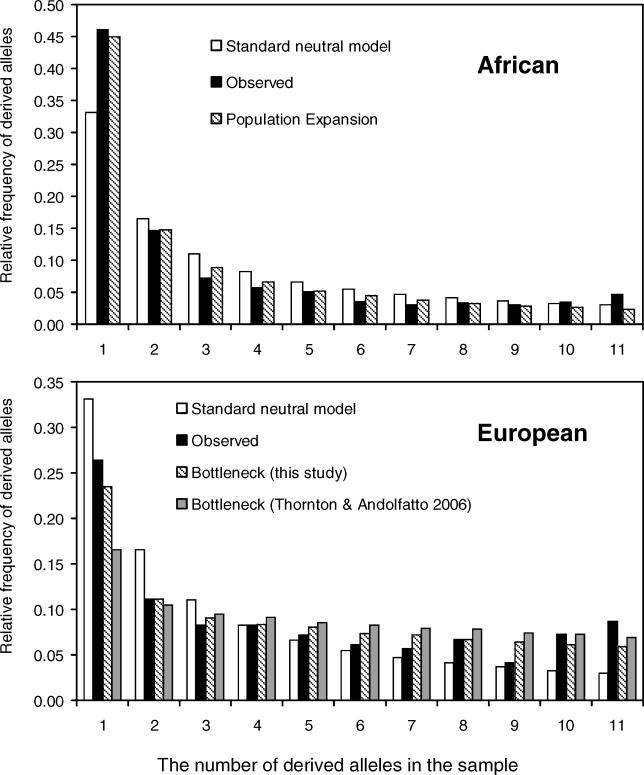
Comparisons of MFSFor the European population, the expected MFSs under our estimated bottleneck scenario and a previously proposed bottleneck scenario [24] are plotted.